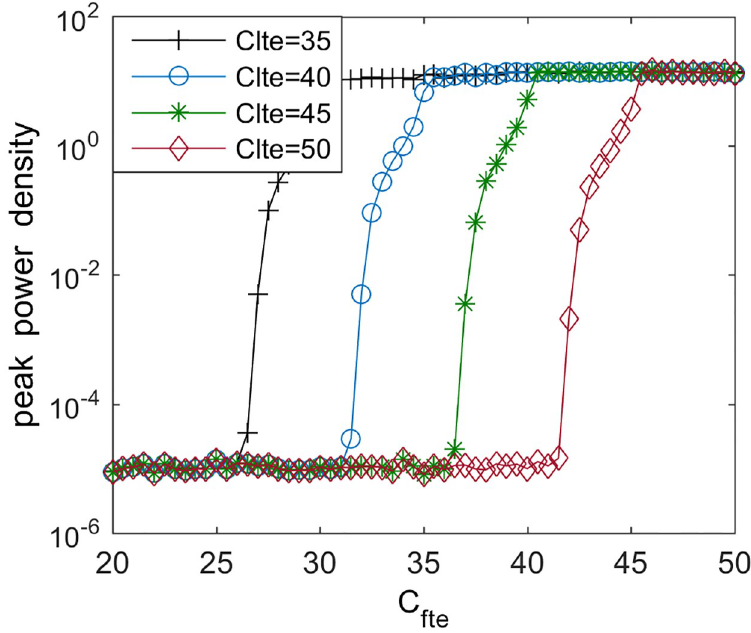
Fig 5. Dependence of the peak power density within alpha band on synaptic connectivity C parameters of C lte . Here, C lte = 35, 40, 45,